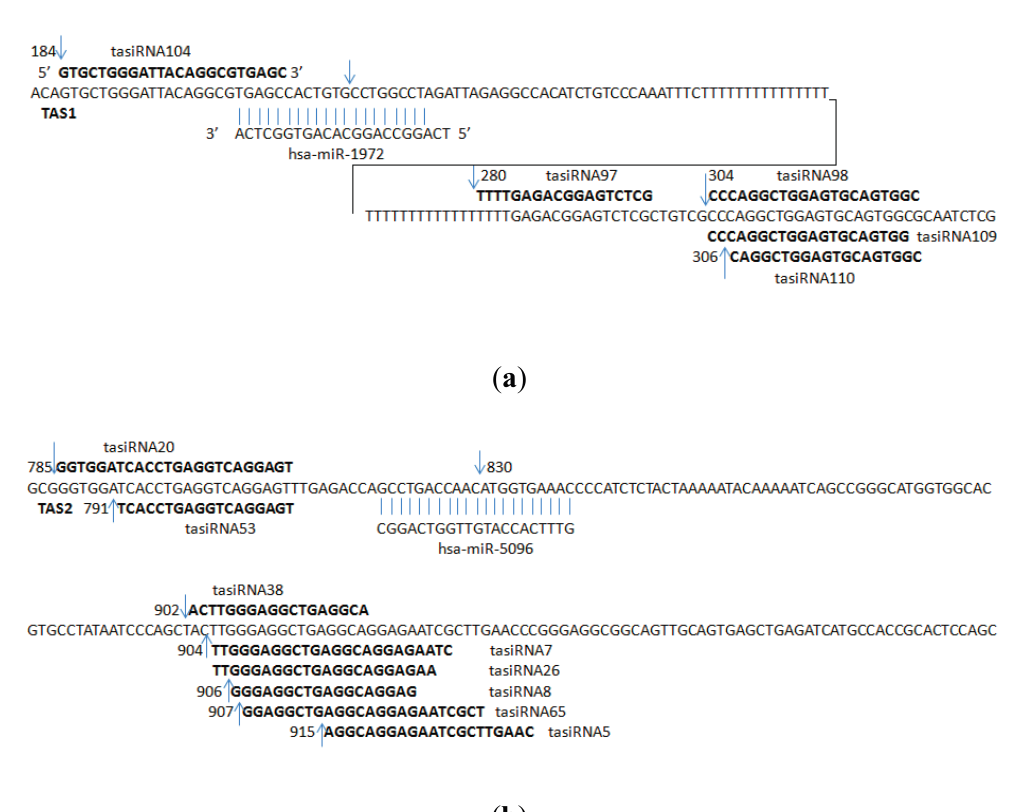
Figure 1. Ta-siRNAs with specific targets site in brain. ( a ) ta-siRNAs targeting DRAXIN, TAS1-hsTAS (ENST00000547850); ( b ) ta-siRNAs targeting ATCAY, TAS2-hsTAS (ENST00000409982). The arrows represent the locations of TAS